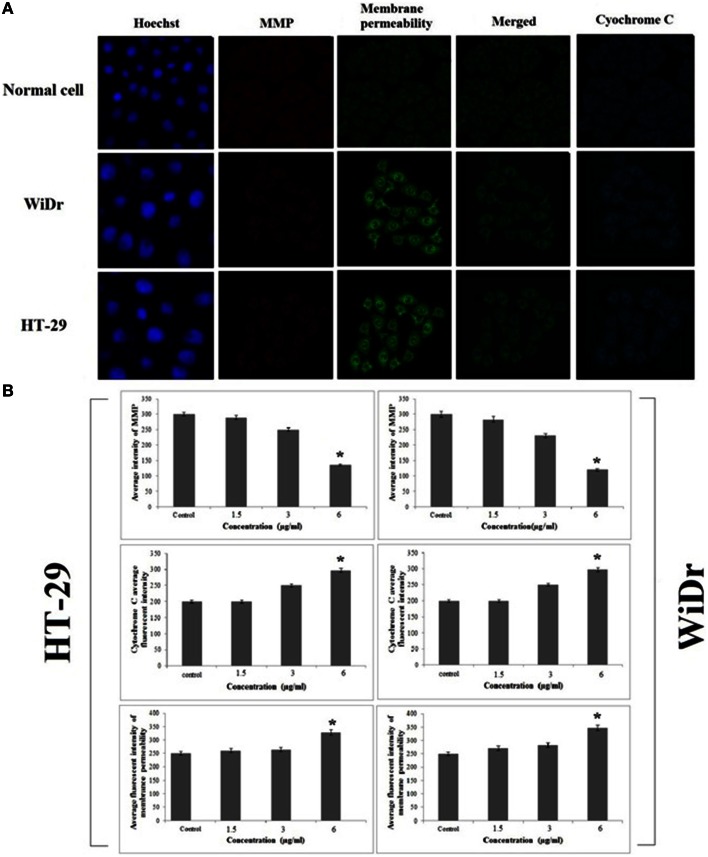
Immunofluorescence study of the effect of NTC. (A) After treatment of the cells with NTC (6.0 μM), Hoechst 33,342, cytochrome c, membrane permeability and mitochondrial membrane potential dyes were applied. (B) Representative bar charts indicate a dose-dependent reduction of MMP (JC-1), elevated cell permeability and cytochrome c release in treated cells. All data were expressed as the means ± standard error of triplicate measurements. *P < 0.05 compared with the no-treatment group.